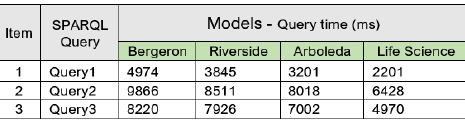
Table 3: SPARQL query